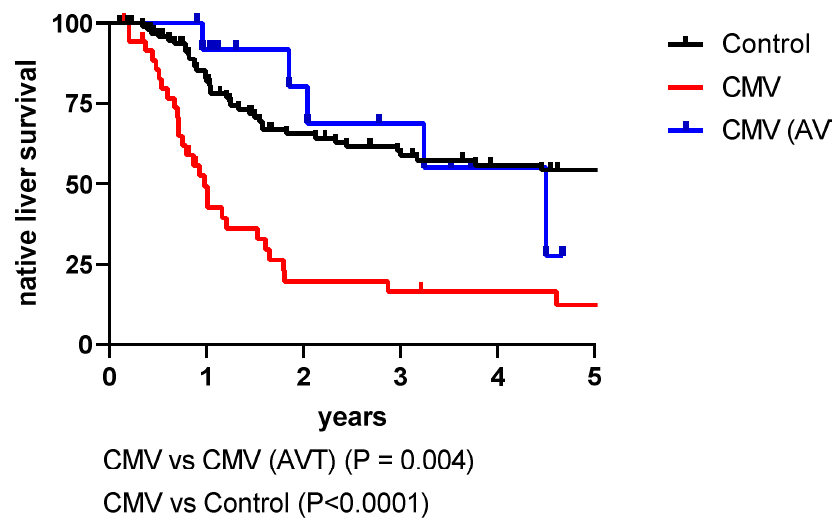
Figure 1. Native-liver survival in cytomegalovirus (CMV) positive patients with biliary atresia, with or without antiviral treatment (AVT) and CMV-negative controls in one of the participating centres (London). Log rank survival.